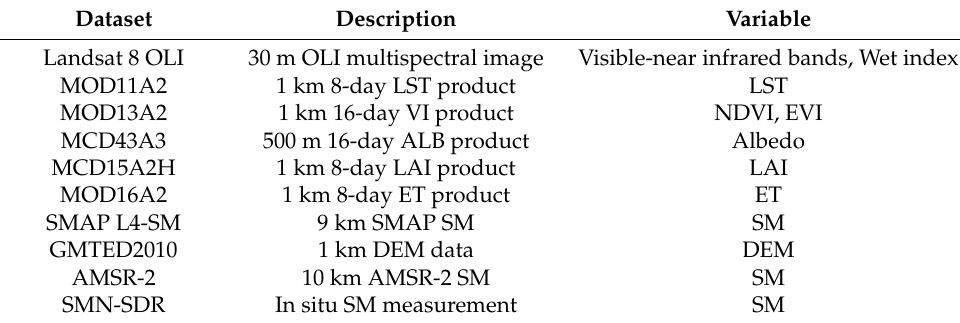
Table 1. Description of datasets used in this